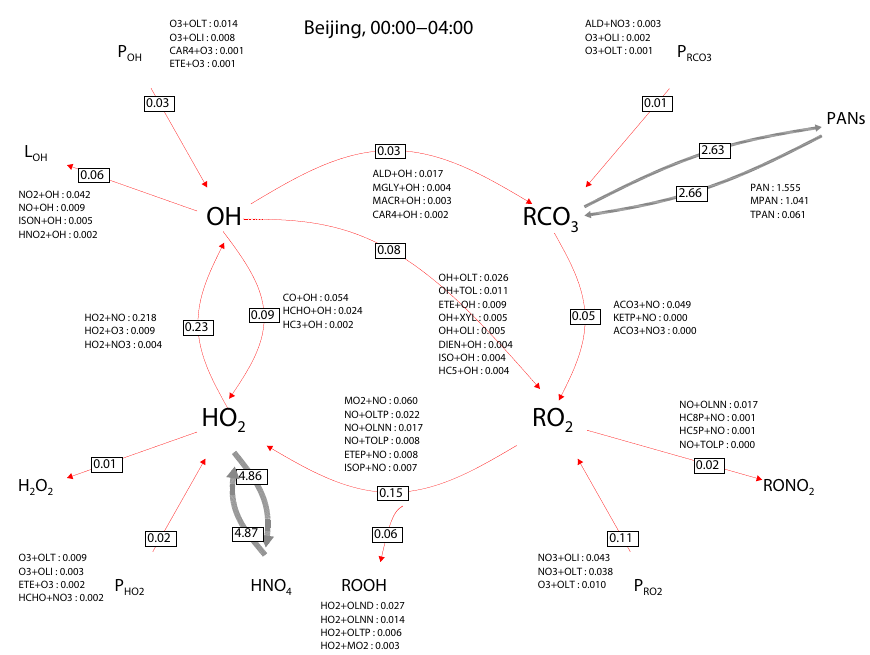
Figure 9. Mean RO x production, conversion, and destruction rates calculated by the base model (M0) for CAREBEIJING2006 conditions during 00:00–04:00CNST. The thickness of the arrows represents the relative magnitude of the reaction rates given in ppbh − 1